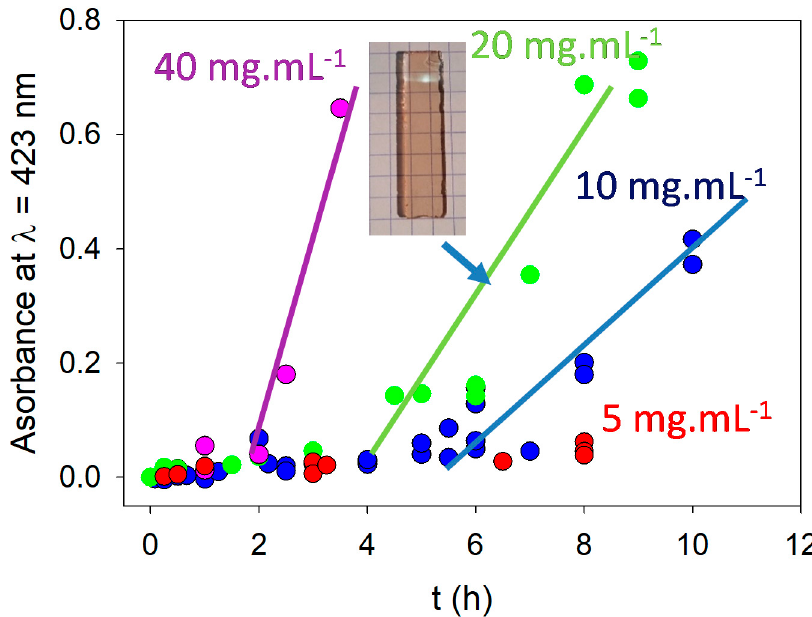
Figure 1. Absorbance at λ = 423. nm of aminomalononitrile (AMN)-based films deposited on quartz slides at different concentrations of AMN: 5 ( • ), 10 ( • ), 20 ( • ) and 40 ( • ) mg · mL − 1 . The lines are aimed to guide the eye and their extrapolation to the time axis yields the induction period preceding the deposition of the AMN based films. The inset is a picture of a quartz slide after 8 h of deposition from a 20 mg·mL − 1 AMN solution. Reproduced with permission from [12], Copyright American Chemical Society, 2019.